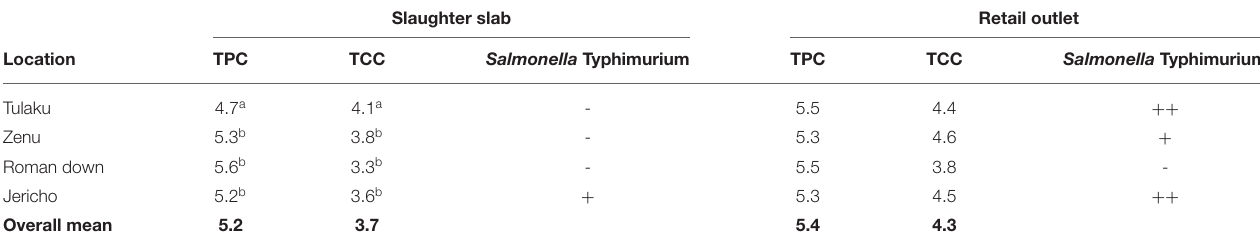
TABLE 5 | Mean microbial count [in Log 10 (CFU)/g] at slaughter slabs/abattoirs and detection of specific pathogens. Slaughter slab